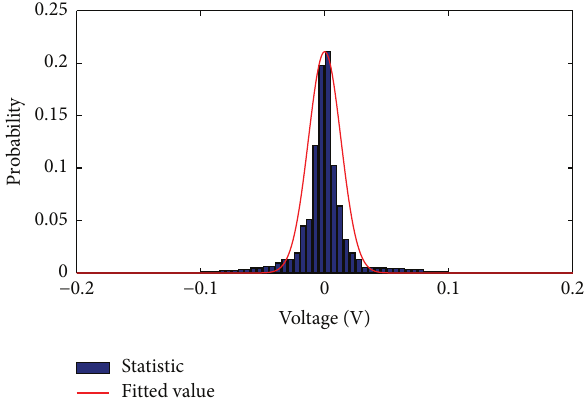
Figure 6: The statistical distribution of the signal